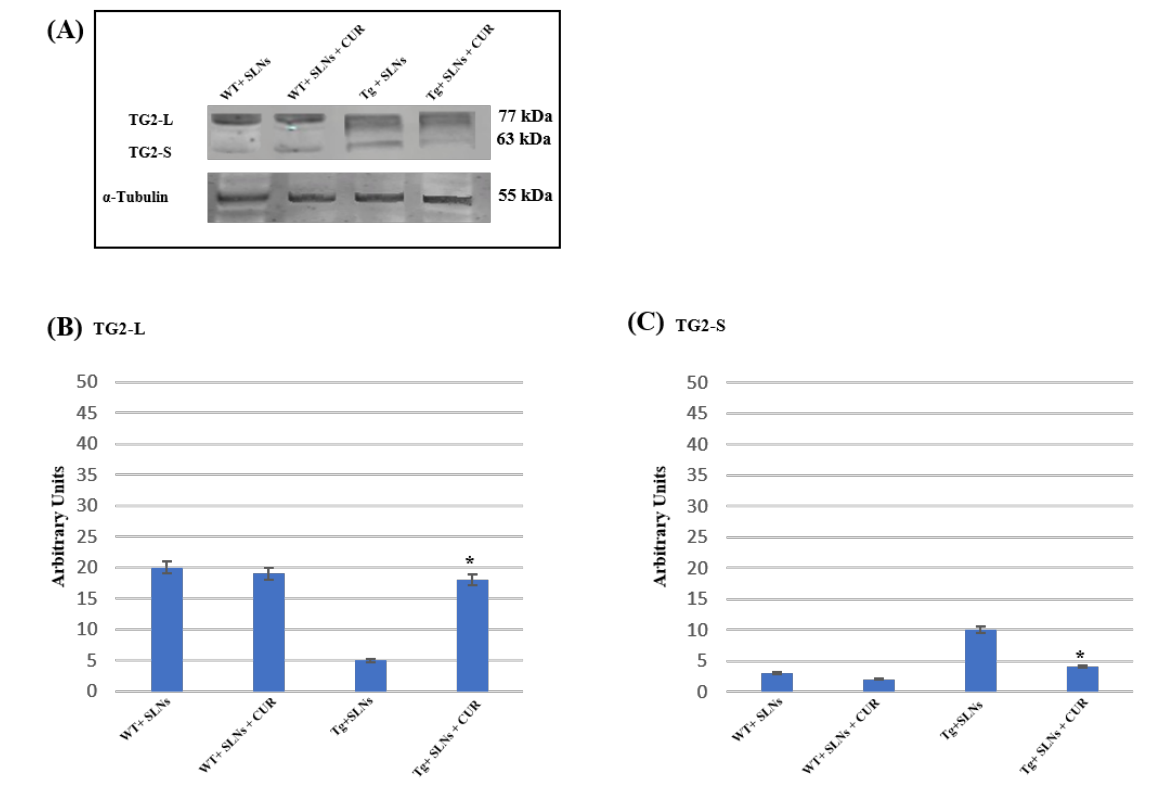
ometric analysis, performed after normalization with α -tubulin, confirmed all the results.